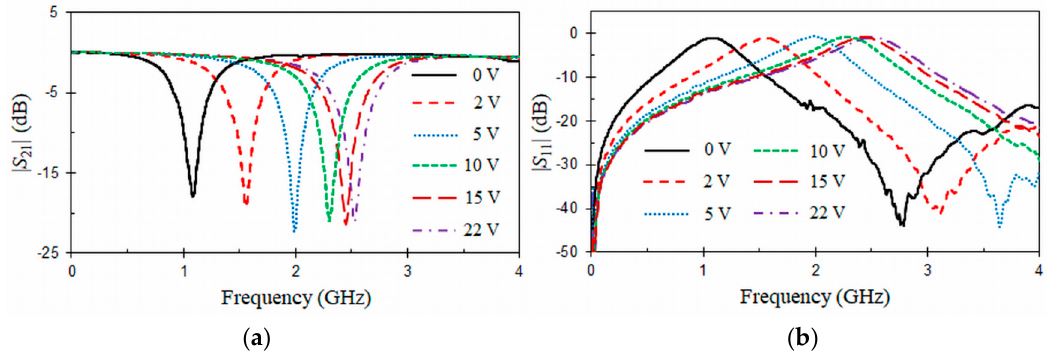
Figure 14. Measured ( a ) | S 21 | (dB) and ( b ) | S 11 | (dB) of the first-order tunable CPW band-stop filter under different DC bias.